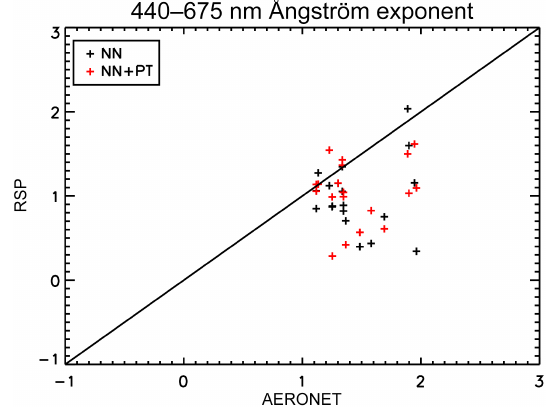
Figure 14. RSP versus AERONET fine-mode effective radius. Black crosses: neural network retrievals. Red crosses: Phillips– Tikhonov with neural network first guess. Statistics shown in Ta- ble